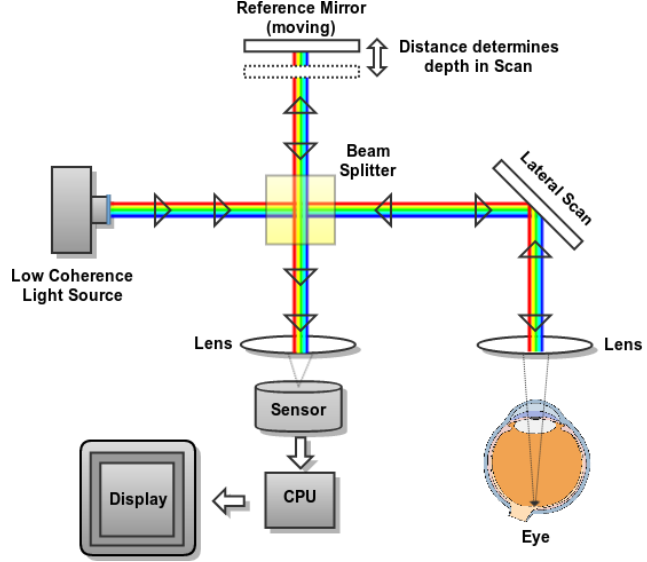
Figure 3. Schema of a basic optical coherence tomography (OCT) acquisition